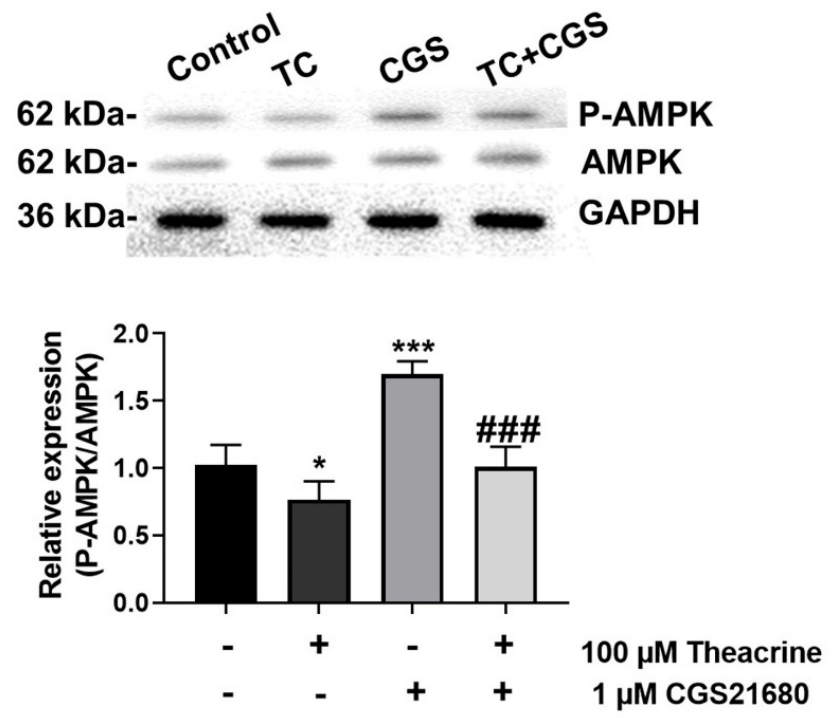
Figure 3. Effects of theacrine on the relative expression of P-AMPK/AMPK induced by CGS21680 in MCF-7 cells. MCF-7 cells were treated with theacrine (100 µ M) and CGS21680 (1 µ M) for 24 h. Cells were harvested and analyzed through western blotting using antibodies against P-AMPK and AMPK.